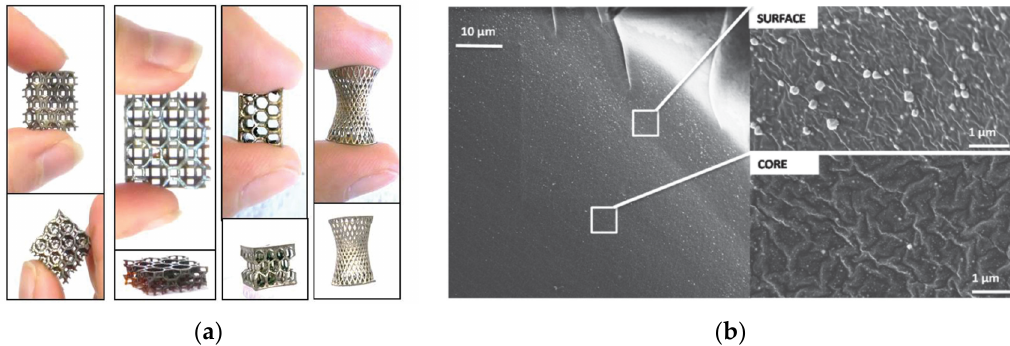
Figure 14. ( a ) Different types of Ag NPs–polymer composite 3D printed structures and ( b ) cross-section Figure 10. phr AgNO 3 where can be seen the difference in the distribution of Ag particles in the surface and in the core. Reproduced from [73] with permission from Wiley.